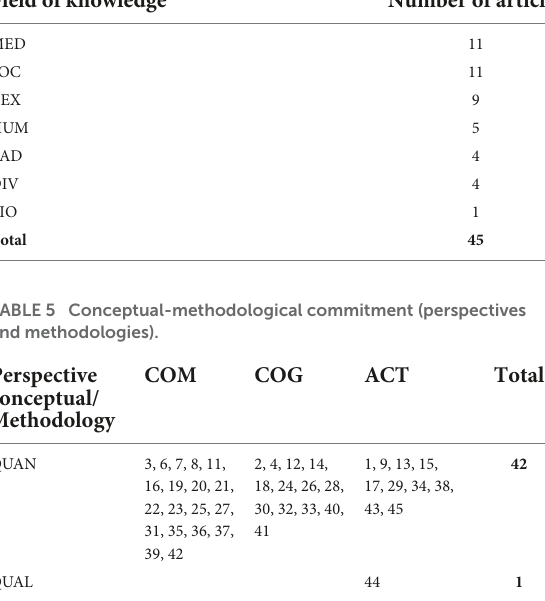
TABLE 4 Fields of knowledge of the analyzed studies. Field of knowledge